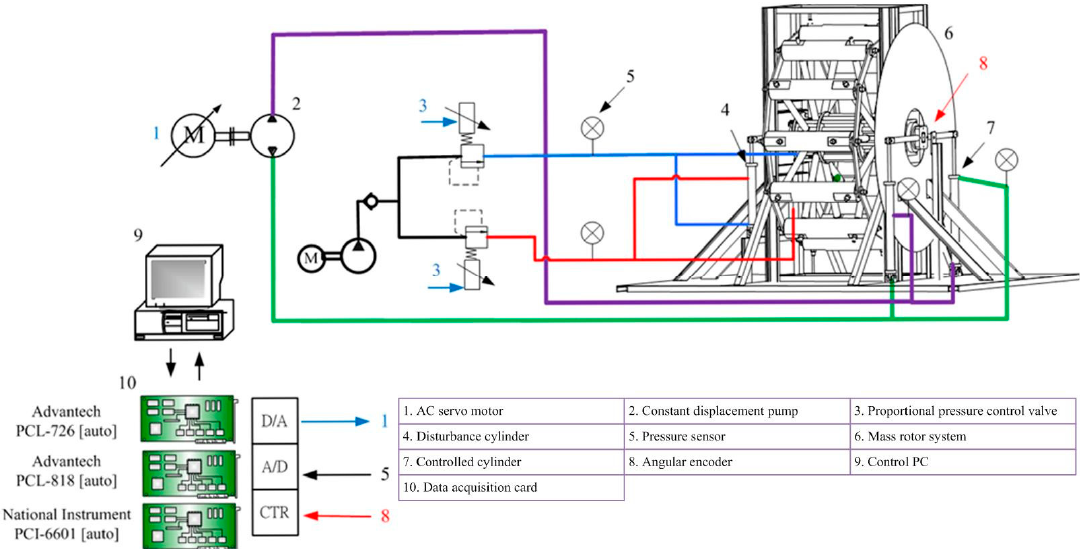
Figure 1. Novel hydraulic pitch control system: ( a ) pitch control by two hydraulic cylinders; ( b ) variable ‐ speed hydraulic pump ‐ controlled system.